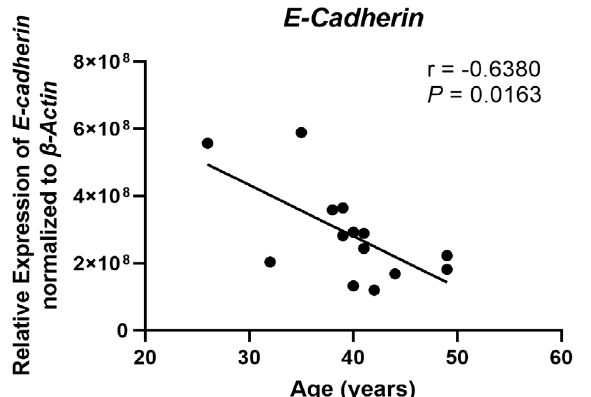
Figure 1. E-cadherin expression decreases with increasing age in premenopausal women. E-cadherin (CDH1) mRNA expression was determined by real-time reverse transcription-polymerase chain reaction (RT-PCR) for endometrial epithelial cells grown in vitro from premenopausal women ( n = 14), isolated from either the proliferative or secretory phase, between the ages of 26–49 years. Expression is normalized to the expression of the housekeeping gene β-Actin . Each symbol represents an individual patient. Non-parametric Spearman correlation